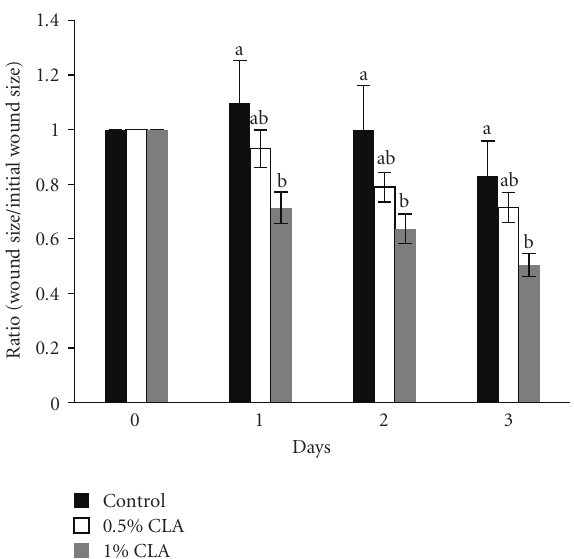
Figure 3: The rate of wound closure in mice fed diets containing 0 (control), 0.5%, or 1% CLA for 2 weeks. The area of the wound of each time point was relative to the area of the wound on d 0 (set at 1.0). Values are means ± SEM; N = 4 to 6 in each group. Means at a time with a di ff erent letter are significantly di ff erent, P < . 05.